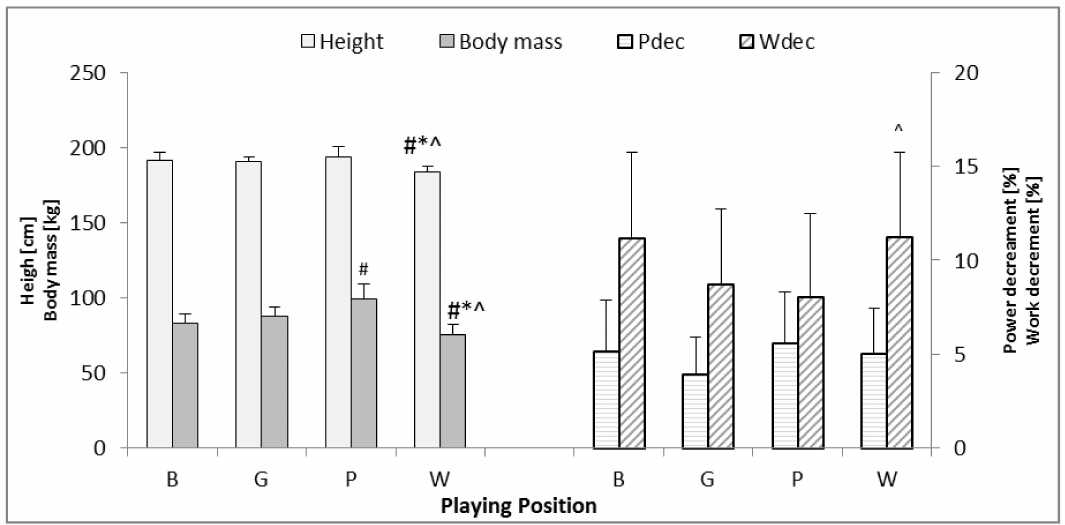
Figure 3. Di ff erences in height, body mass, work decrement (W dec ), and power decrement (P dec ) in the RSA test for athletes of various playing positions. B—backs, G—goalkeepers, P—pivots, W—wings, #—significantly di ff erent from B, *—significantly di ff erent from G, ˆ—significantly di ff erent from